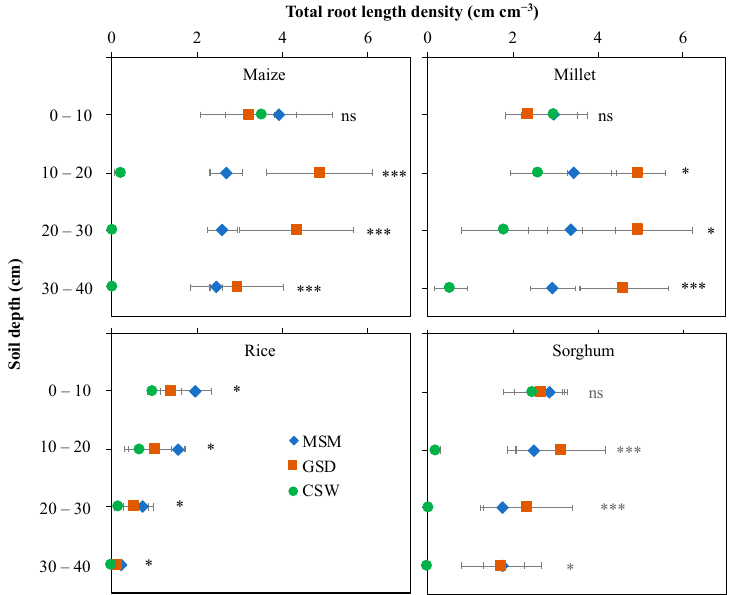
Agronomy 2021 , 11 , x FOR PEER REVIEW 10 of 17 Figure 3. Effect of moderate soil moisture (MSM ( ◆ )), gradual soil drying (GSD ( ■) and continuous soil waterlogging Figure 3. Effect of moderate soil moisture (MSM ( (cid:7) )), gradual soil drying (GSD ( (cid:4) ) and continuous (CSW ( ● )) on the total root length density distribution in different soil layers in maize, millet, rice, and sorghum. *, ***, and ns indicate statistical significance at p < 0.05, p < 0.001, and nonsignificance, respectively. Bar values indicate means ± soil waterlogging (CSW ( • )) on the total root length density distribution in different soil layers in standard deviation. GSD in the 0–10 cm ( p < 0.05) soil layer, and CSW in the 0–10 cm soil layer ( p < 0.001). In maize, millet, rice, and sorghum. *, ***, and ns indicate statistical significance at p < 0.05, p < 0.001, sorghum, in the 0–10 cm soil layer, it showed a significantly higher total root length den ‐ Figure 4 demonstrates the vertical total root length density distribution in different sity in the middle than in the sides for MSM ( p < 0.001), GSD ( p < 0.05) and CSW ( p < 0.001). and nonsignificance, respectively. Bar values indicate means ± standard deviation. soil columns (sides and middle). The sides related to shallower root angle, and the middle However, other soil layers were not significantly different between the middle and the related to steeper root angle, especially in the 0–20 cm soil layer. In maize, root density of sides for all treatments, except in the 10–20 soil layer for MSM ( p < 0.05). the sides were higher than the middle in MSM, but those of GSD were higher in the middle than sides in the 0–40 cm soil layer. Under CSW, as we explained above in Figure 3, most of the root distribution was not able to elongate in subsoil layer (20–40 cm soil layer); total root length density of maize was significant in the middle, higher than in the sides ( p < 0.001). In millet, total root length density distribution in comparison between MSM and GSD showed a similar trend, with the middle showing a higher total root length density distribution than the sides in the 0–40 cm soil layer. Under CSW, the total root length density distribution in the 0–10 cm soil layer was significantly ( p < 0.001 ) higher in the middle than in the sides, but in the 10–40 cm soil layer, significantly had no difference between the middle and the sides. In rice, total root length density was significantly higher in the middle than in the sides for MSM in the 0–10 cm and 20–40 cm soil layers ( p < 0.05),